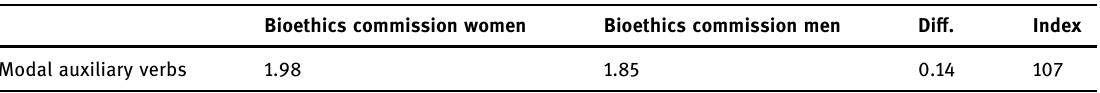
Table 5: Word list extract: comparison of modal auxiliary occurrences as per cent of total tokens ( normalised, n = 1,000 )